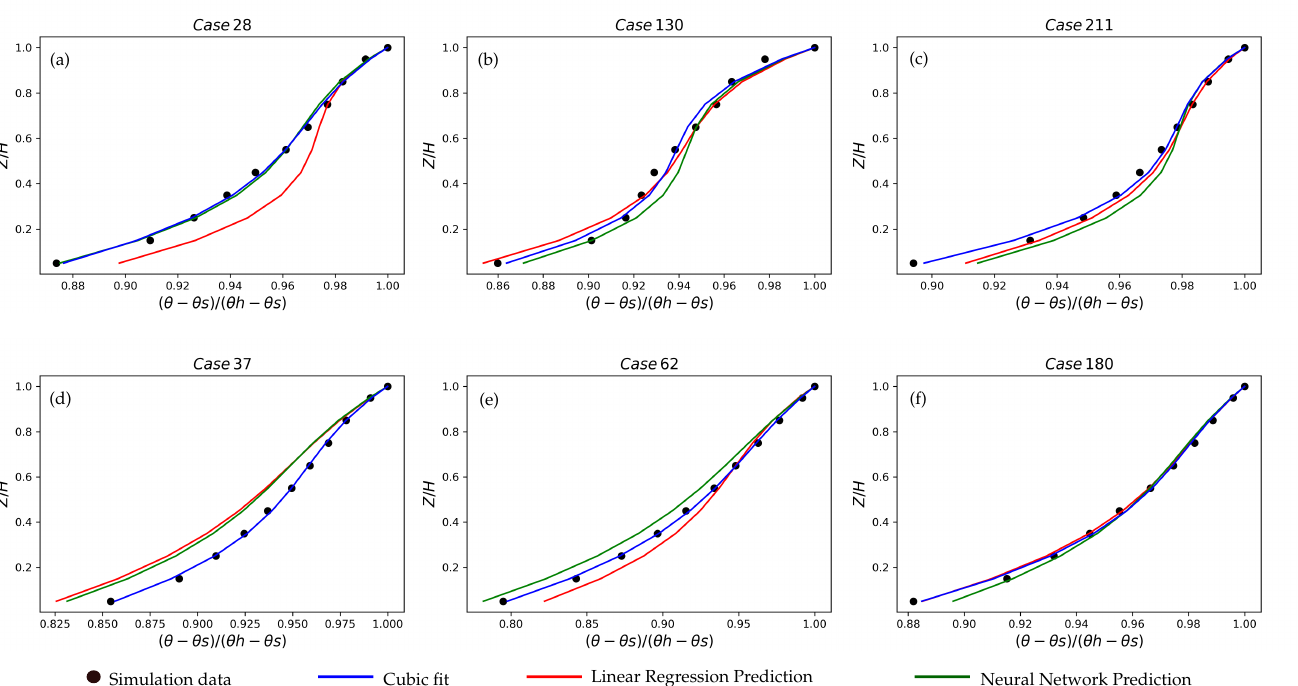
Figure 13. Cubic polynomial velocity prediction: linear regression vs. ANN for unstable cases ( a – c ) and stable cases ( d – f ).